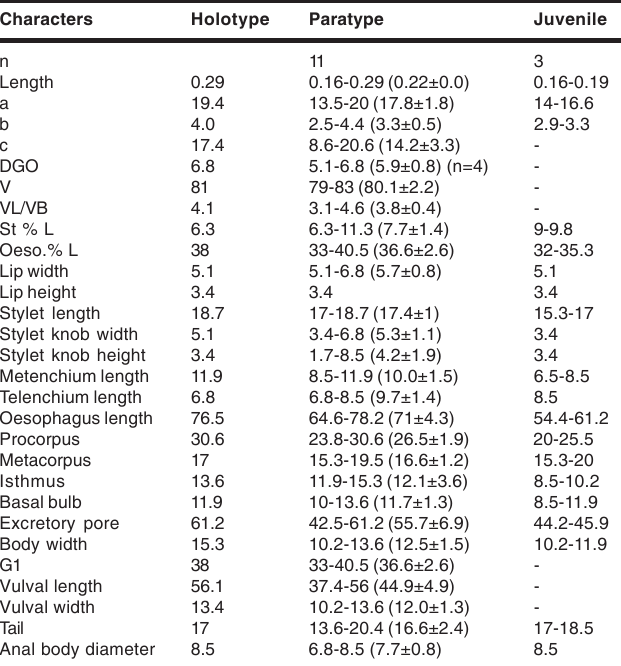
Table 2. Measurements of the females of Paratylenchus thysanolus sp. nov. All measurements in μ m, except L in